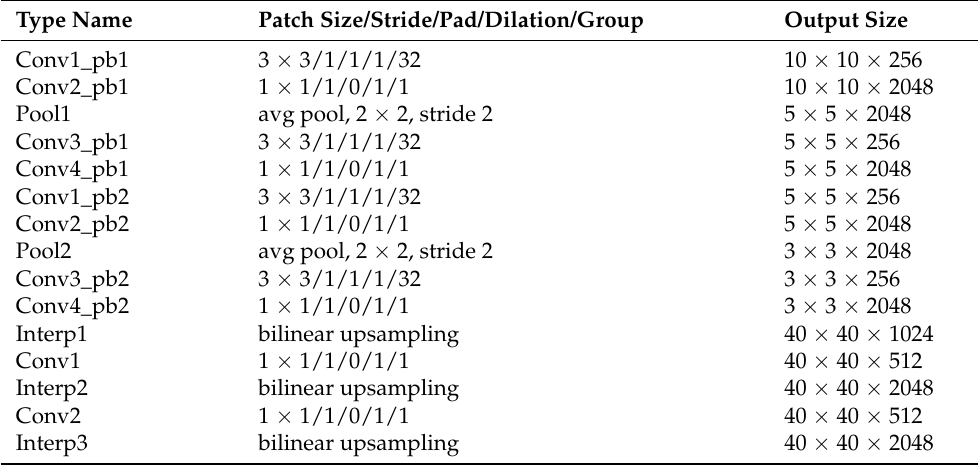
Table 1. Main configurations for CSNet. Note that x and y are integers in the range [1, 5]. Type